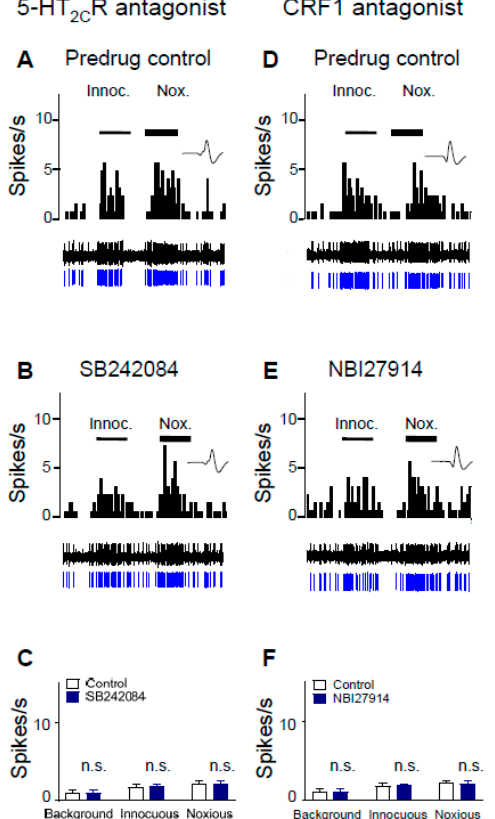
Figure 4. 5-HT 2C R knockdown eliminated the inhibitory effect of antagonists for 5-HT 2C R (SB242084) and CRF1 receptors (NBI27914) on CeA neurons in a neuropathic pain model. CeA neurons were recorded in SNL rats 2 weeks after 5-HT 2C R shRNA was injected into the BLA, i.e., 4 weeks post SNL surgery. Background activity and evoked responses to innocuous (100 g/6 mm 2 ) and noxious (500 g/6 mm 2 ) stimulation of the left hindpaw are shown. ( A , B ) SB242084 (100 µM concentration in microdialysis fiber; 15 min; ( B )) had no effect in an individual CeA neuron compared to predrug control (ACSF; ( A )). Same display as in Figure 3. ( C ) Summary of lack of significant effects of SB242084 on CeA neurons ( n = 6 neurons; p > 0.05, paired t -test compared to predrug). ( D , E ) NBI27914 administered into BLA (100 µM concentration in microdialysis fiber; 15 min; ( E )) had no effect in an individual CeA neuron compared to predrug control (ACSF, ( D )). ( F ) Summary of the lack of significant effects of NBI27914 on CeA neurons ( n = 6 neurons; n.s., not significant, p > 0.05, paired t -test compared to predrug).